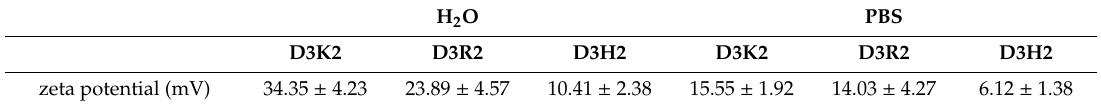
Table 1. Zeta potential values of PLL dendrimers (average ± SD, n = 6).